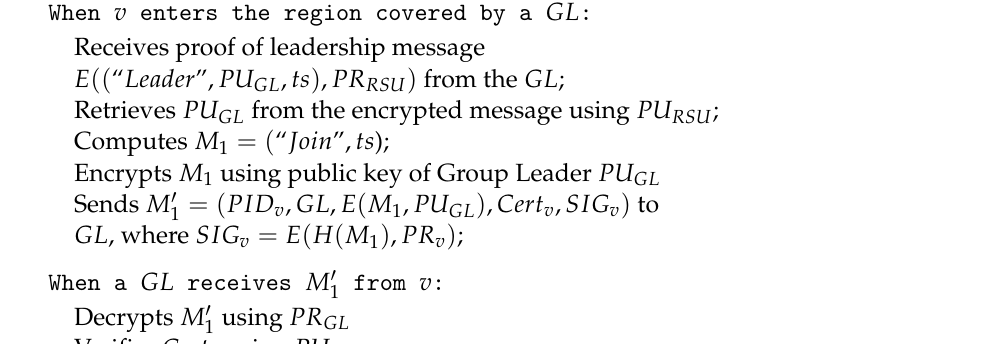
Algorithm 3: When vehicle v enters a sub-region covered by a Group Leader GL When v enters the region covered by a GL